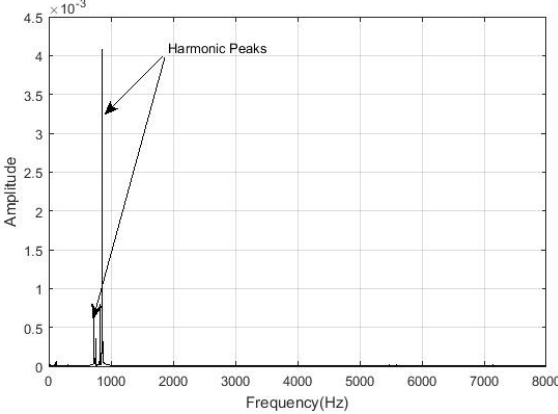
Figure 13. One broken bar signal spectrum before the noise reduction with the harmonic peaks.